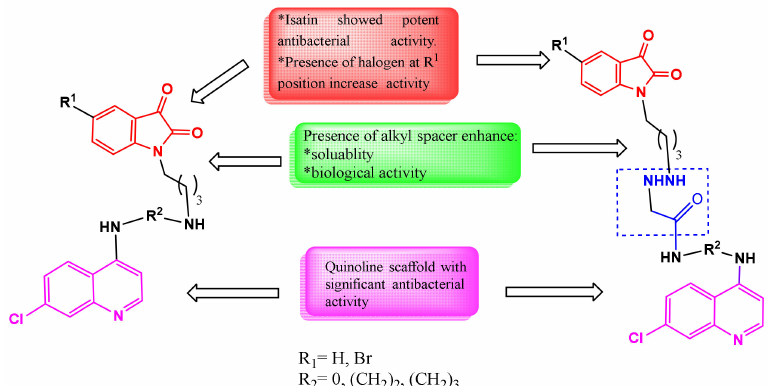
Figure 1. Design strategy for target conjugates containing isatin–quinoline